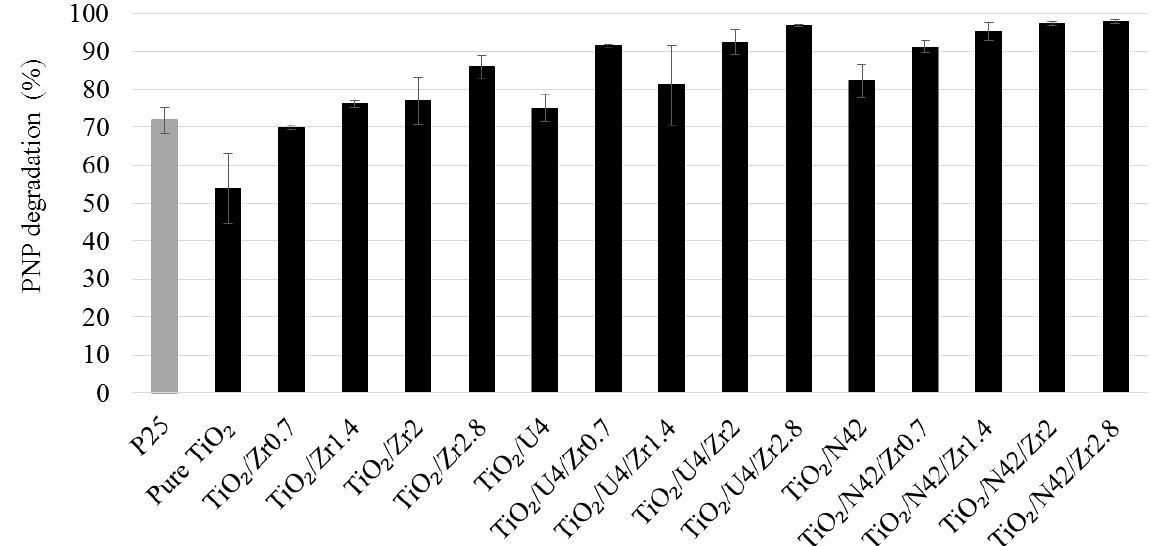
Figure 8. PNP degradation percentage for all the samples under UV/visible light after 8 h of illumination.